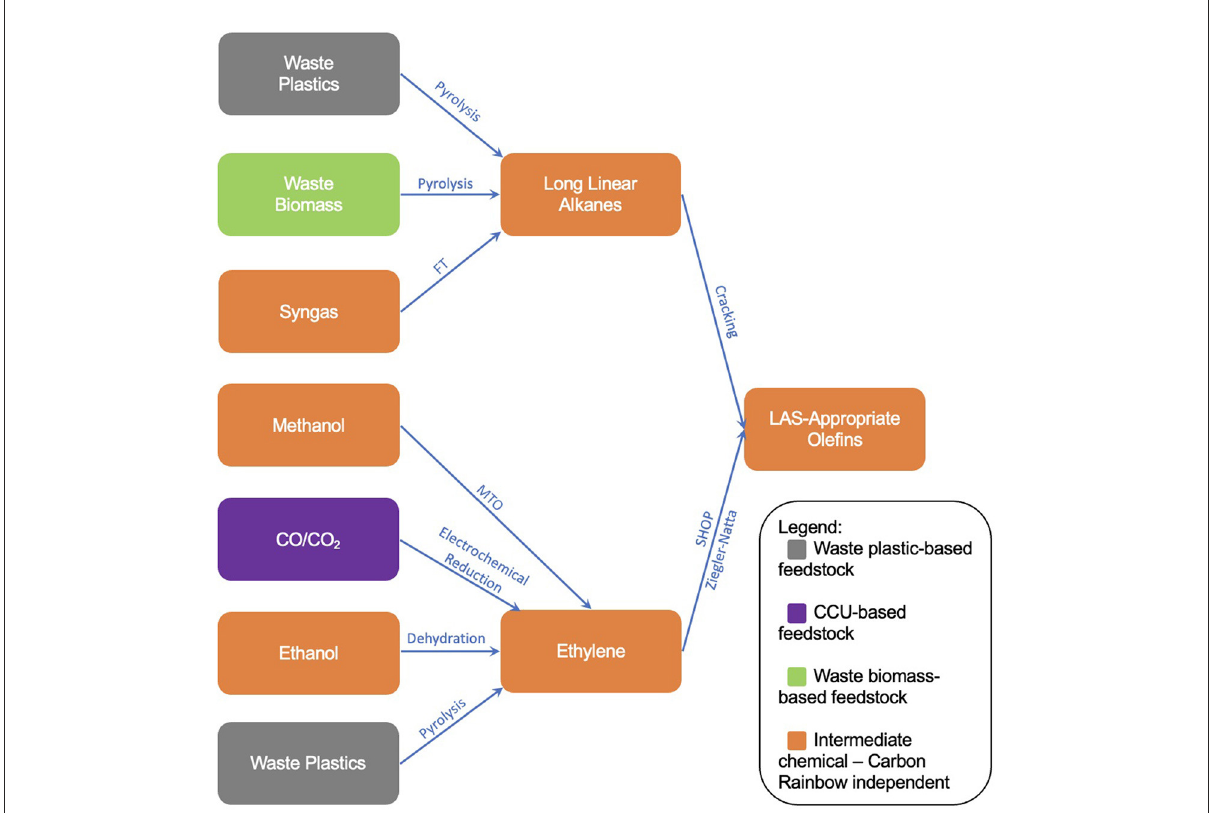
FIGURE9 Tree diagram for the formulation of LAS-appropriate olefins from first- and second-degree platform